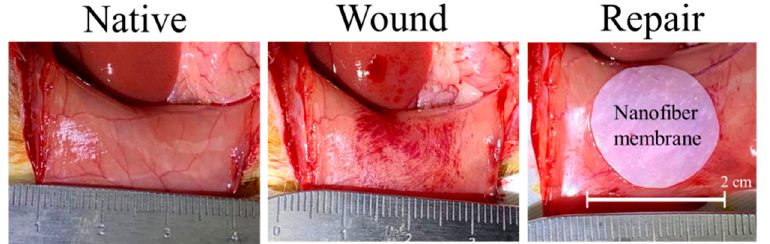
Figure 9. A wound was created on the native parietal peritoneum after abrading, followed by repair with a 2-cm PCL/CS nanofiber membrane, with or without mesothelial